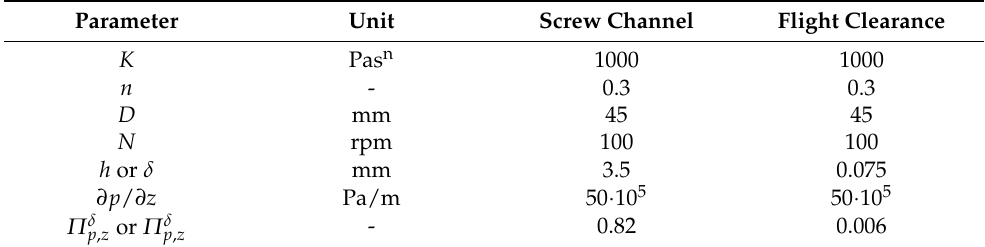
Table 1. Dimensionless pressure gradients in the screw channel Π p , z and in the flight clearance Π δ p , z . Parameter Unit Screw Channel Flight Clearance K Pas n 1000 1000